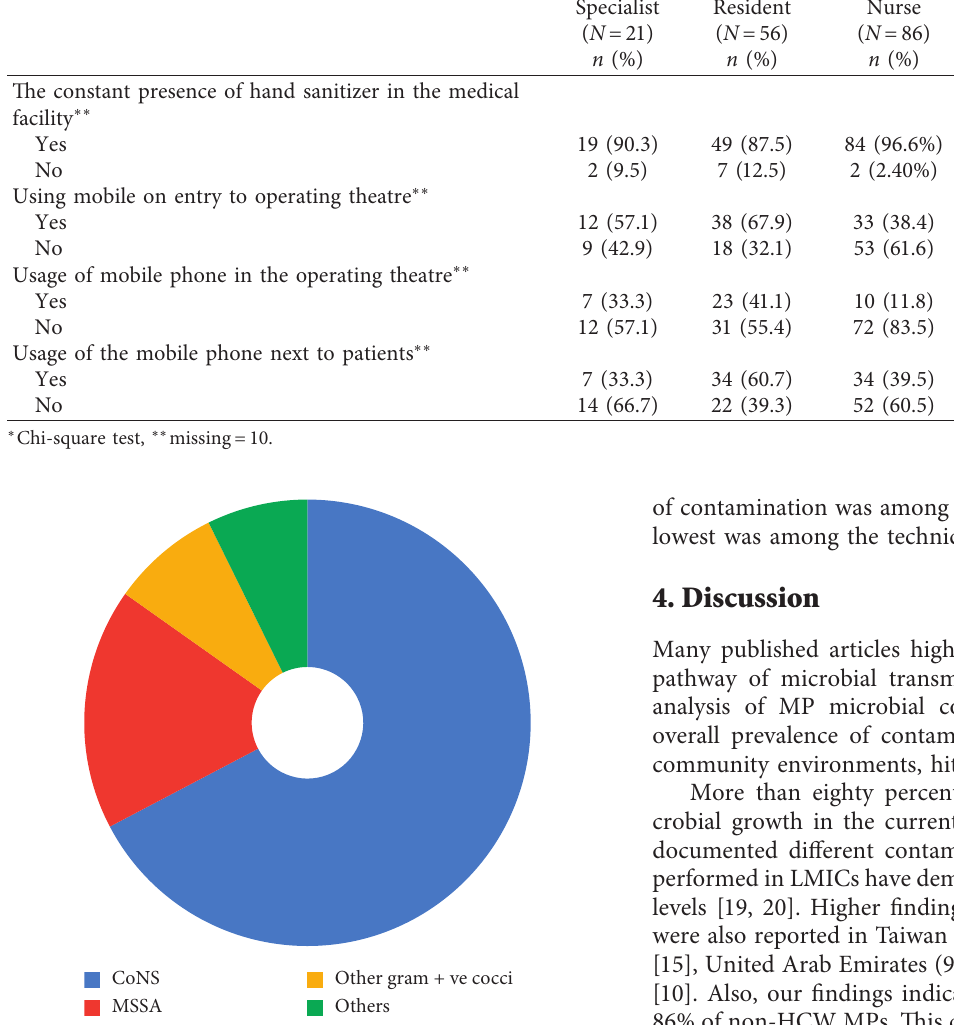
Figure 1: Distribution of bacterial isolates from HCW